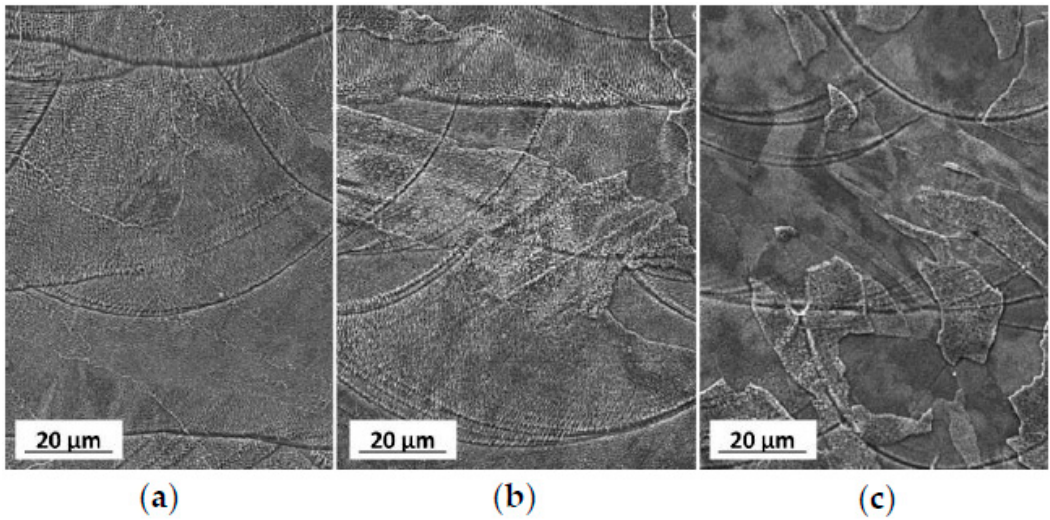
Figure 13. SEM images showing cross-section microstructures at melt-pool level of L-PBF 316 L steel in ( a ) as-built condition, and after annealing at ( b ) 800 °C/15 min and ( c ) 900 °C/15 min [135].